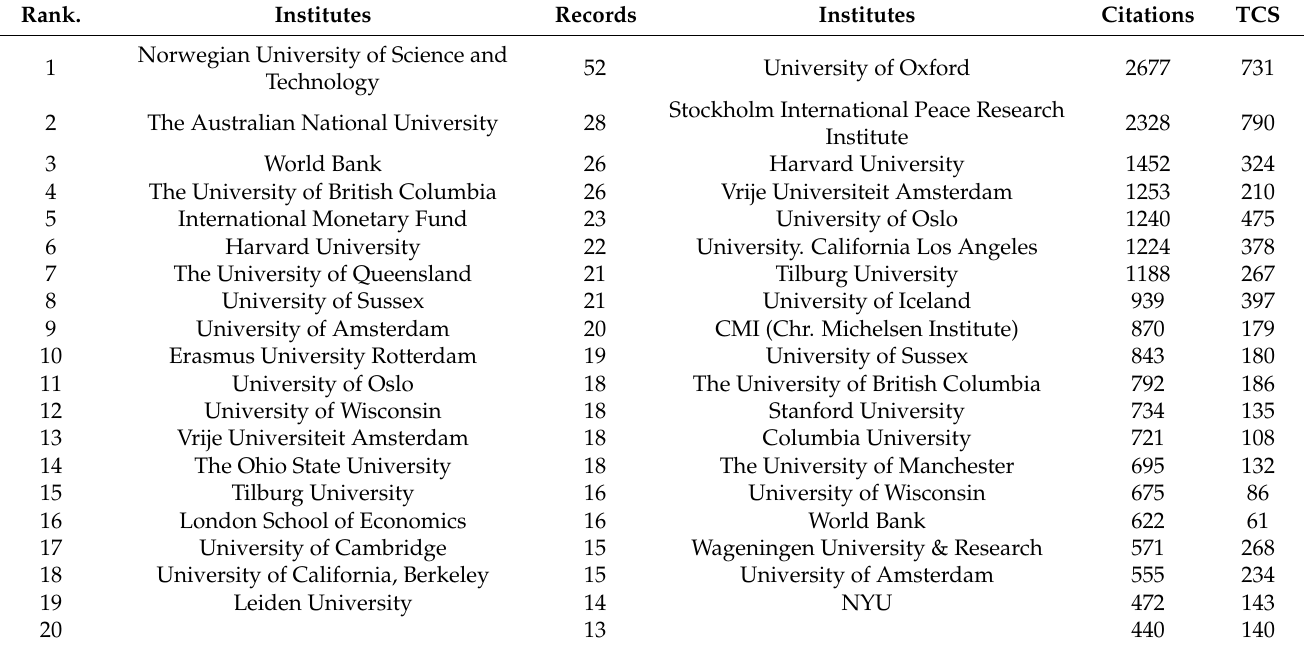
Table 2. The top 20 institutes with documents and